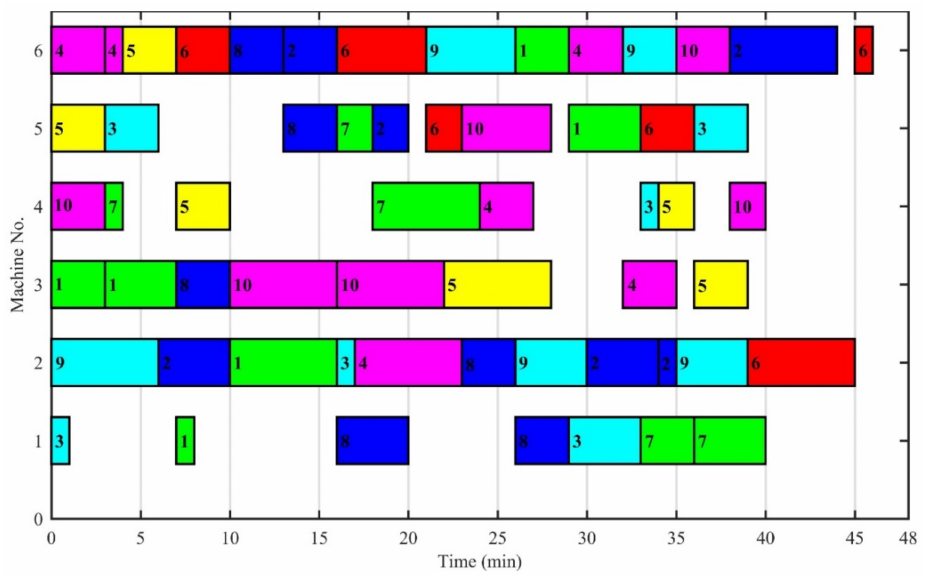
Figure 4. The scheduling scheme. Table 8. The component